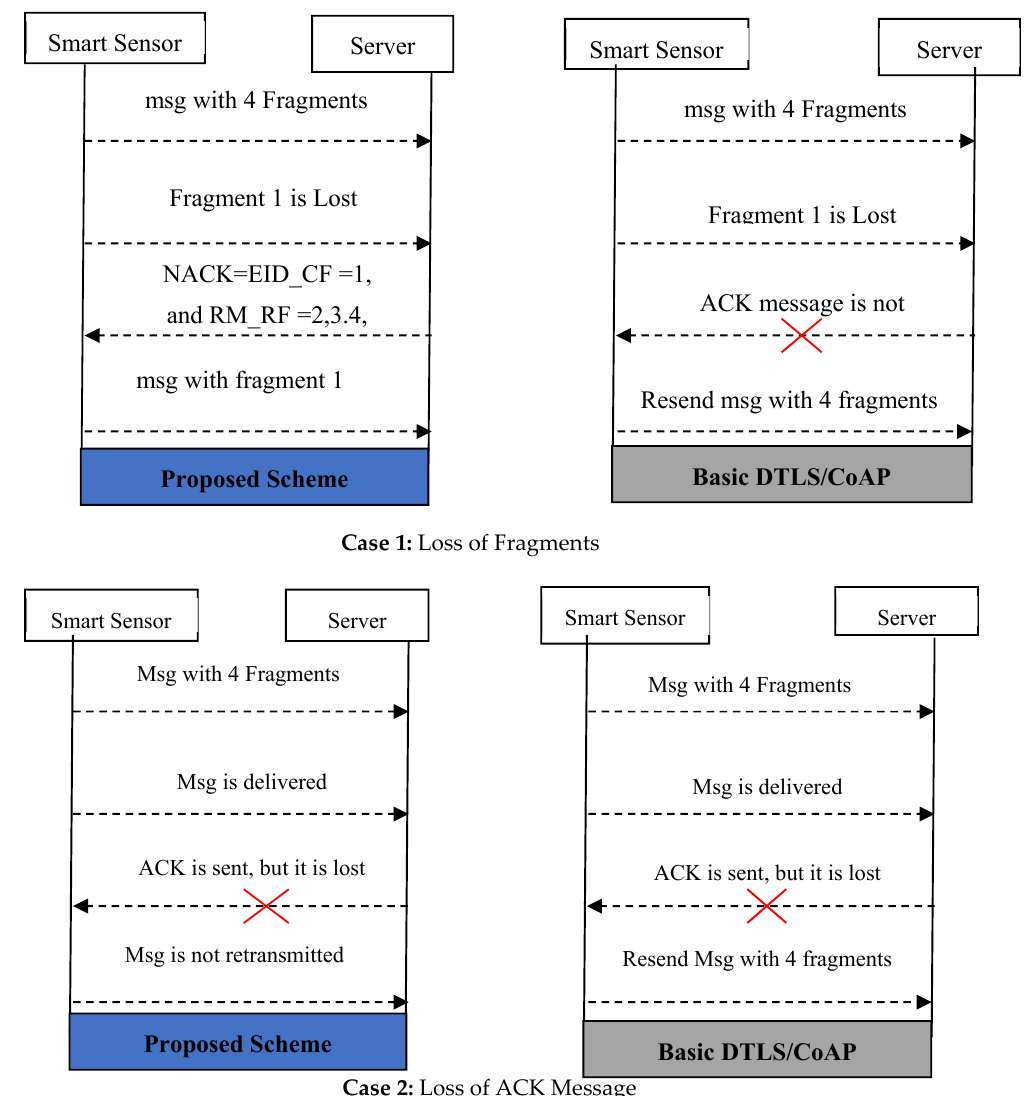
Figure 5. Communication between Server and Smart Sensors